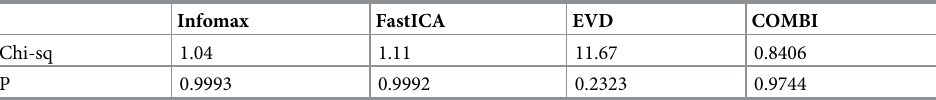
Table 1. Repetition number k did not influence Iq values for non-deterministic ICA (sensory